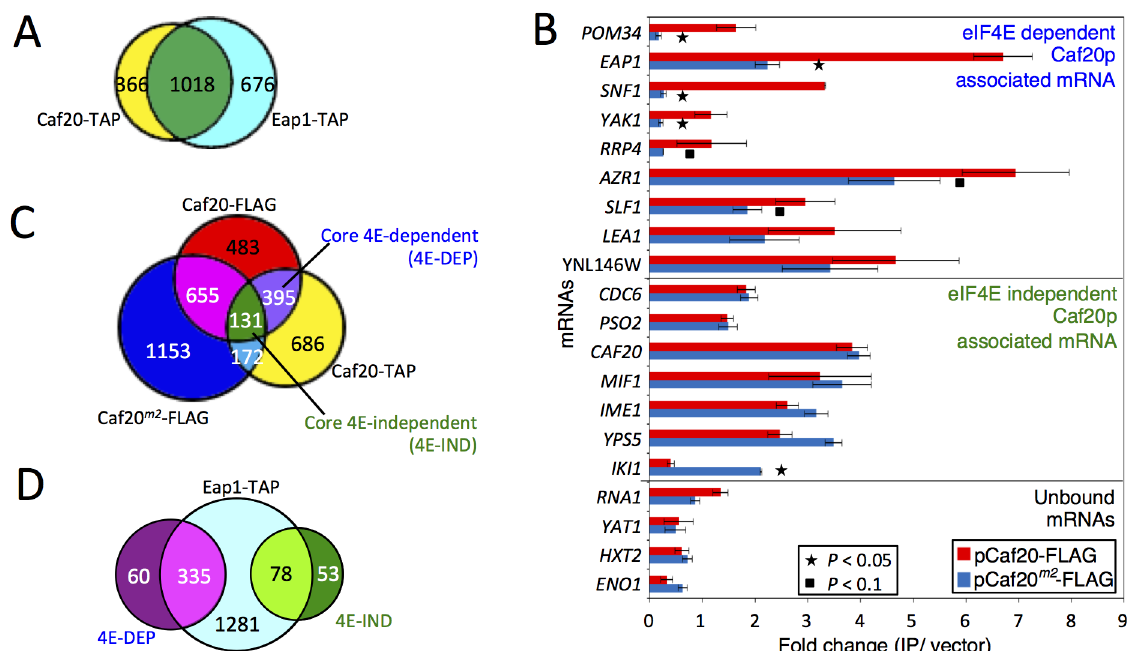
Fig 4. Identifying eIF4E-dependent and independent mRNAs associating with Caf20p. A. Proportional Venn style diagram showing the overlap between the mRNAs associating with Caf20p and Eap1p TAP IPs. B. Quantitative RT-PCR of selected mRNAs showing their association with Caf20p and Caf20 m2 p represented as fold-change over control. Statistically significant changes are indicated with a key (T-test). C. and D. Venn style diagrams showing C. mRNAs associating with Caf20-TAP, Caf20-FLAG and Caf20 m2 -FLAG, highlighting the core mRNAs identified in both studies and their dependence on the eIF4E interaction motif for binding, and D. Overlap between the core 4E-DEP and 4E-IND Caf20p interacting mRNAs and the Eap1-TAP associated